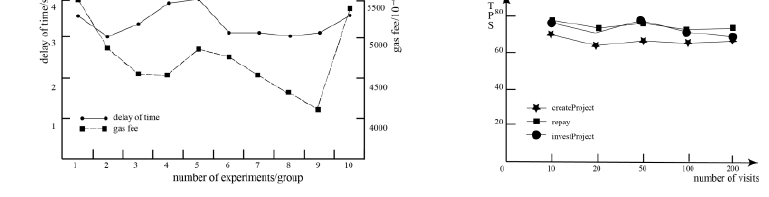
Fig. 5. Analysis diagram of create project. Fig. 6. Throughput of write data.